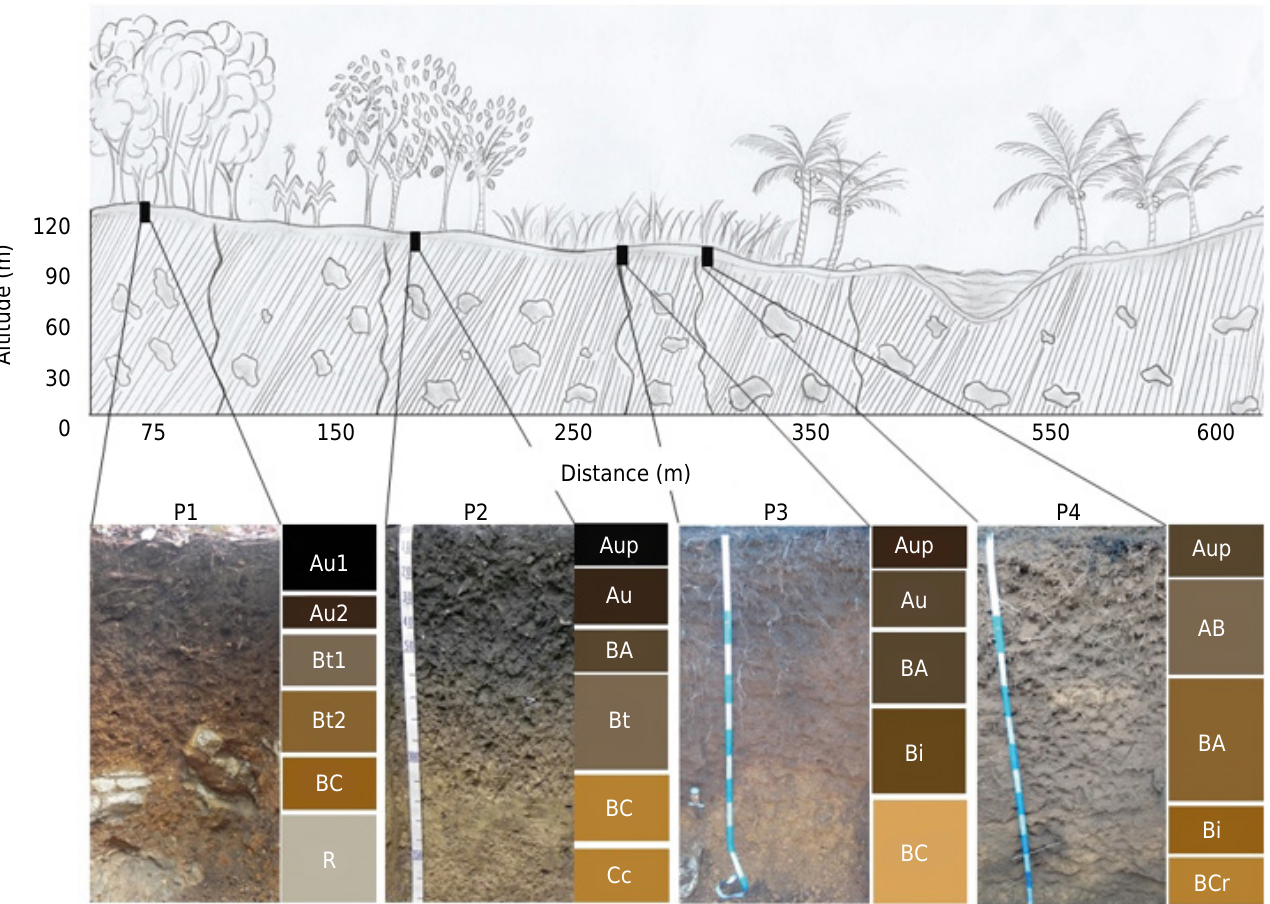
Figure 2. Location of the four profiles of the volcanic toposequence studied in Apuí